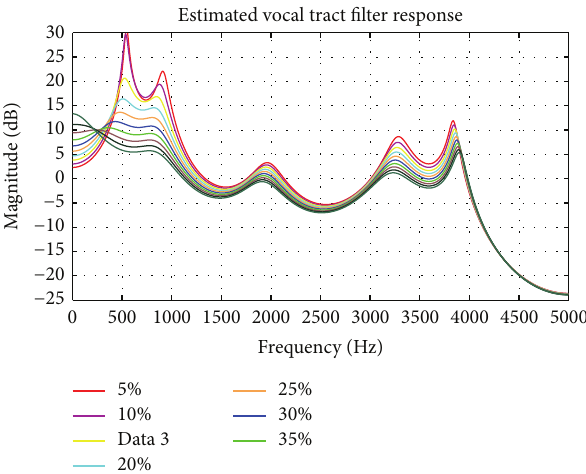
Figure 10: Variations in the formant parameters due to change in LPC coefficients for a